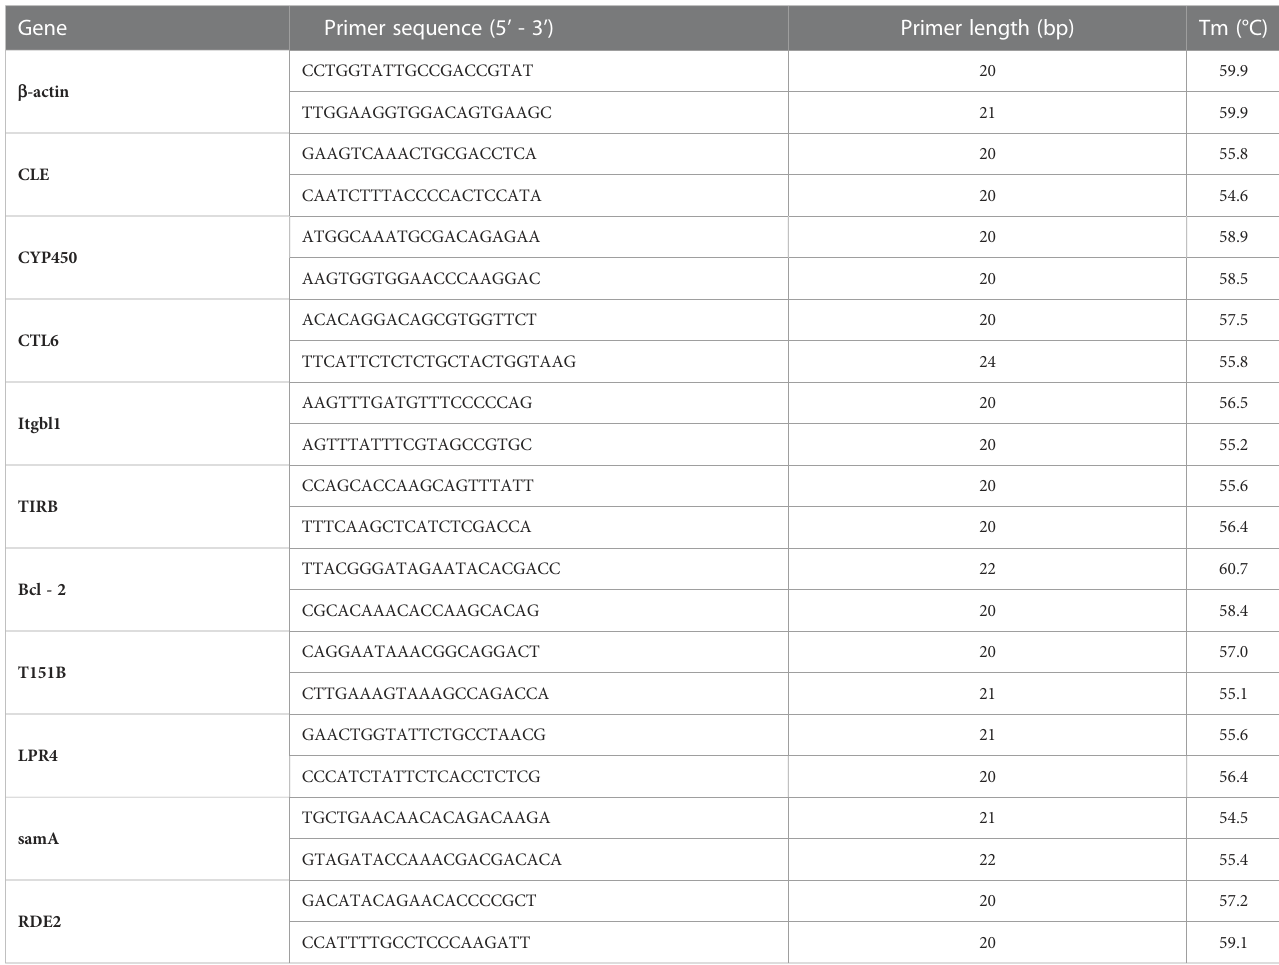
TABLE 1 Primer sequence for qRT-PCR veri fi cation.